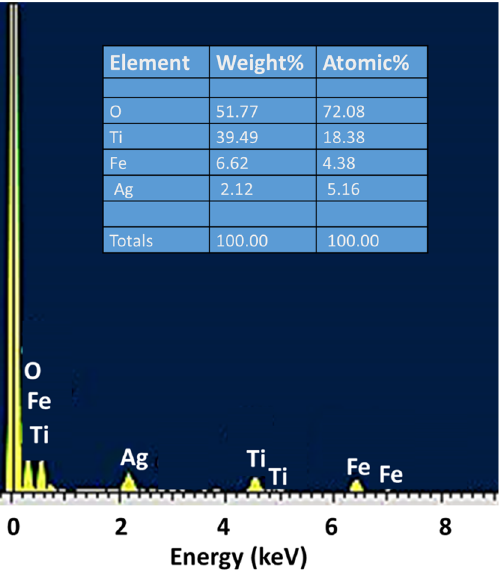
Figure 6. EDS spectrum of Fe 2 O 3 -Ag 2 O/TiO 2 nanocatalyst.